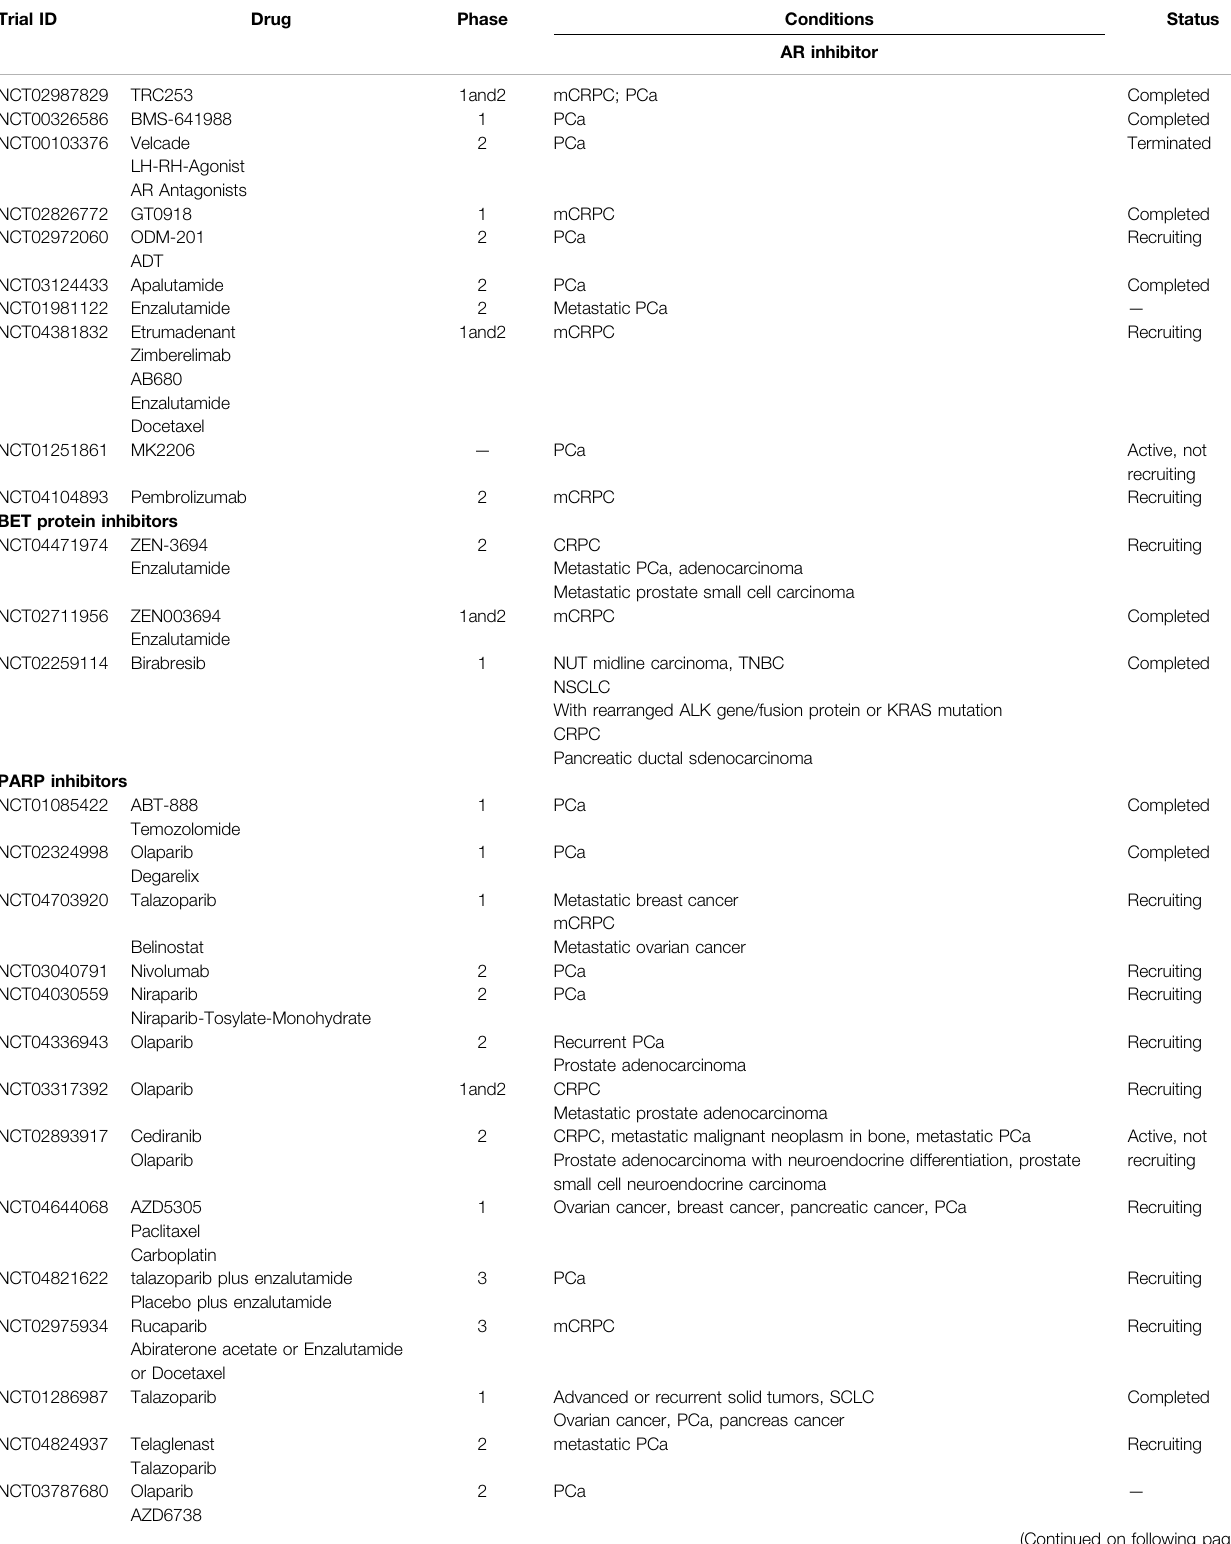
TABLE 4 | Development of epigenetic